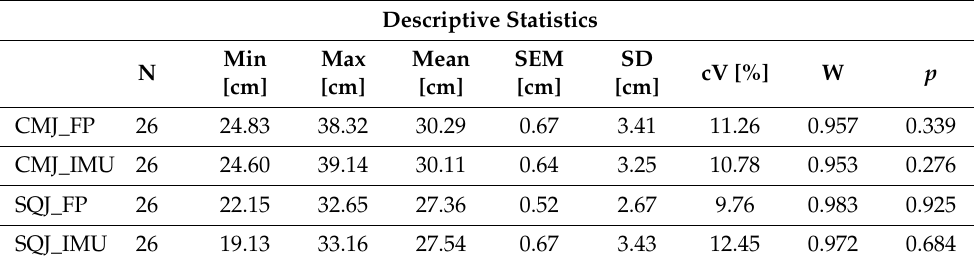
Table 1. Descriptive statistics and normality of the distribution of counter-movement (CMJ) and squat jump (SQJ) height, as estimated based on the flight-time (FT) determined from a force plate (FP) and an inertial measurement unit (IMU).